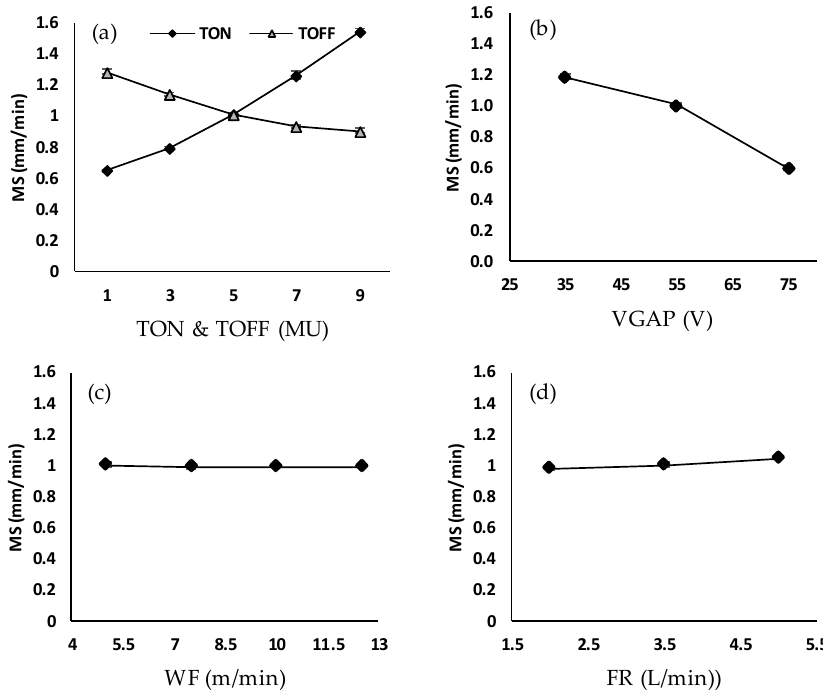
Figure 5. E ff ect of ( a ) pulse-on time and pulse-o ff time, ( b ) average voltage gap, ( c ) wire feed and Figure 5. Effect of ( a ) pulse-on time and pulse-off time, ( b ) average voltage gap, ( c ) wire feed and ( d ) ( d ) flow rate on machining speed flow rate on machining speed (MS).